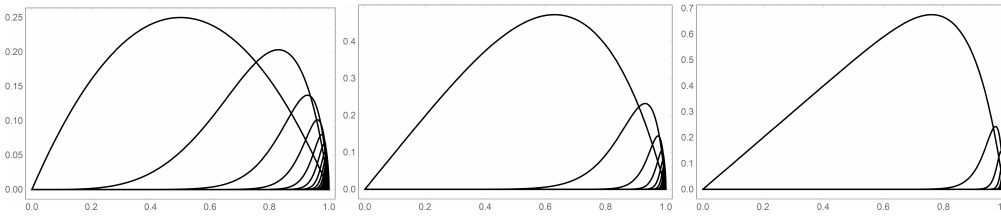
Figure 3. Cyclic decompositions for the centered polygonal lacunary functions along the line segments at α 1 for (left-to-right) k = 1, k = 3 (sames as in Figure 2), and k = 8. The other parameters are the same as in Figure 2. Increasing k skews the graph towards the natural boundary.